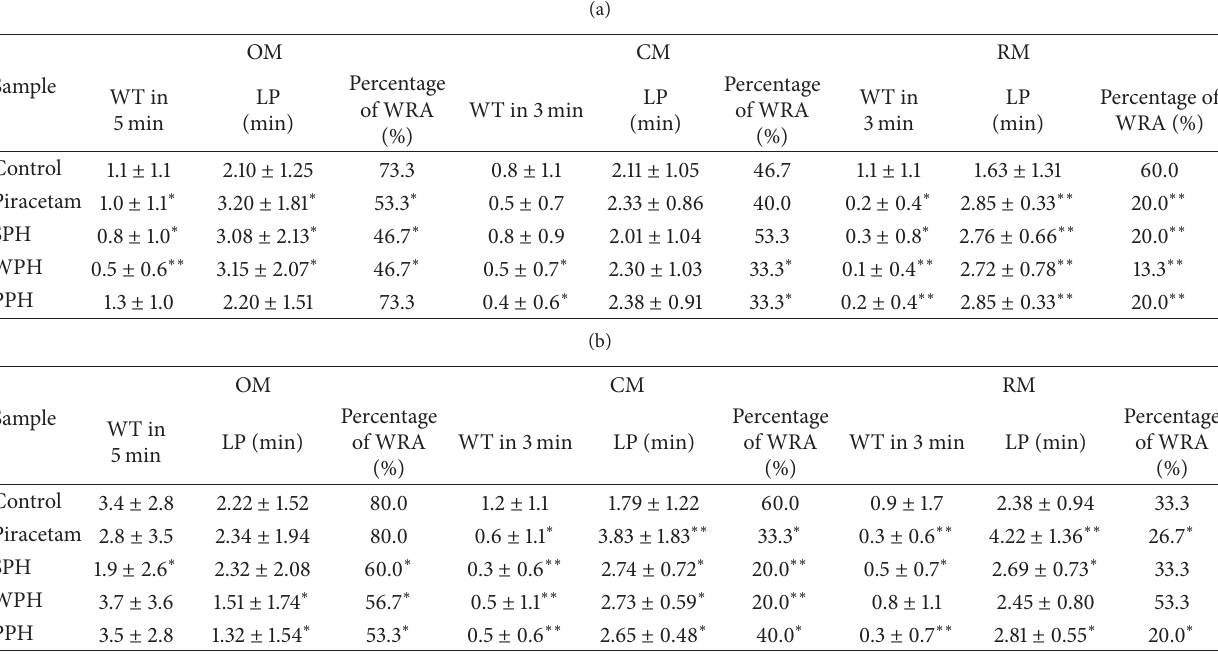
Table 3: Effects of SPH, WPH, and PPH on memory acquisition, consolidation, and retrieval in normal mice in step-down test in normal and anisodine-treated